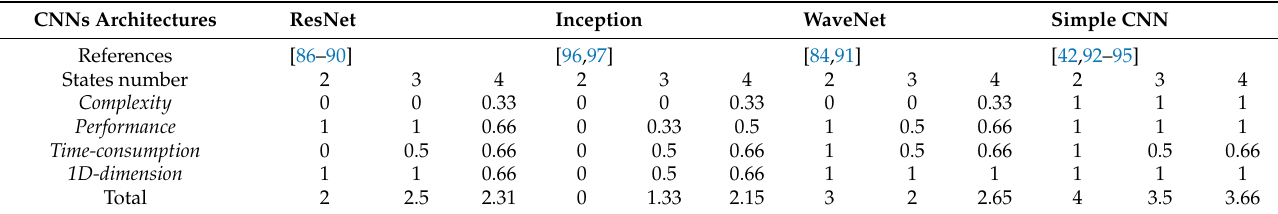
Table 3. The architectures scores with 2, 3, and 4